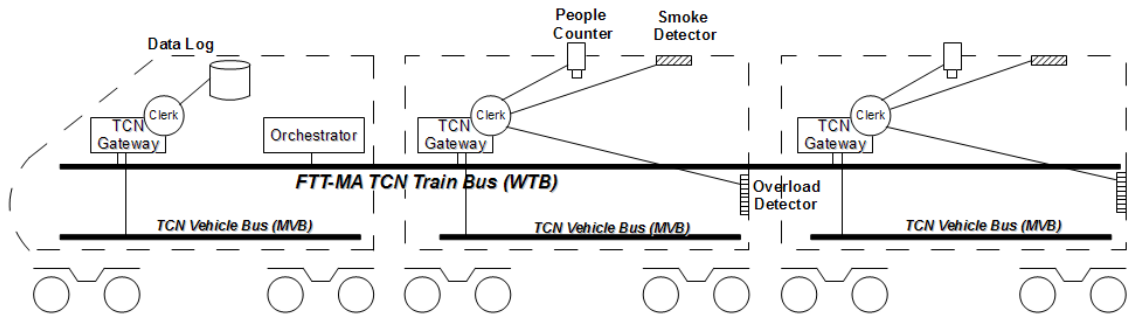
Figure 7. FTT-MA governed TCN